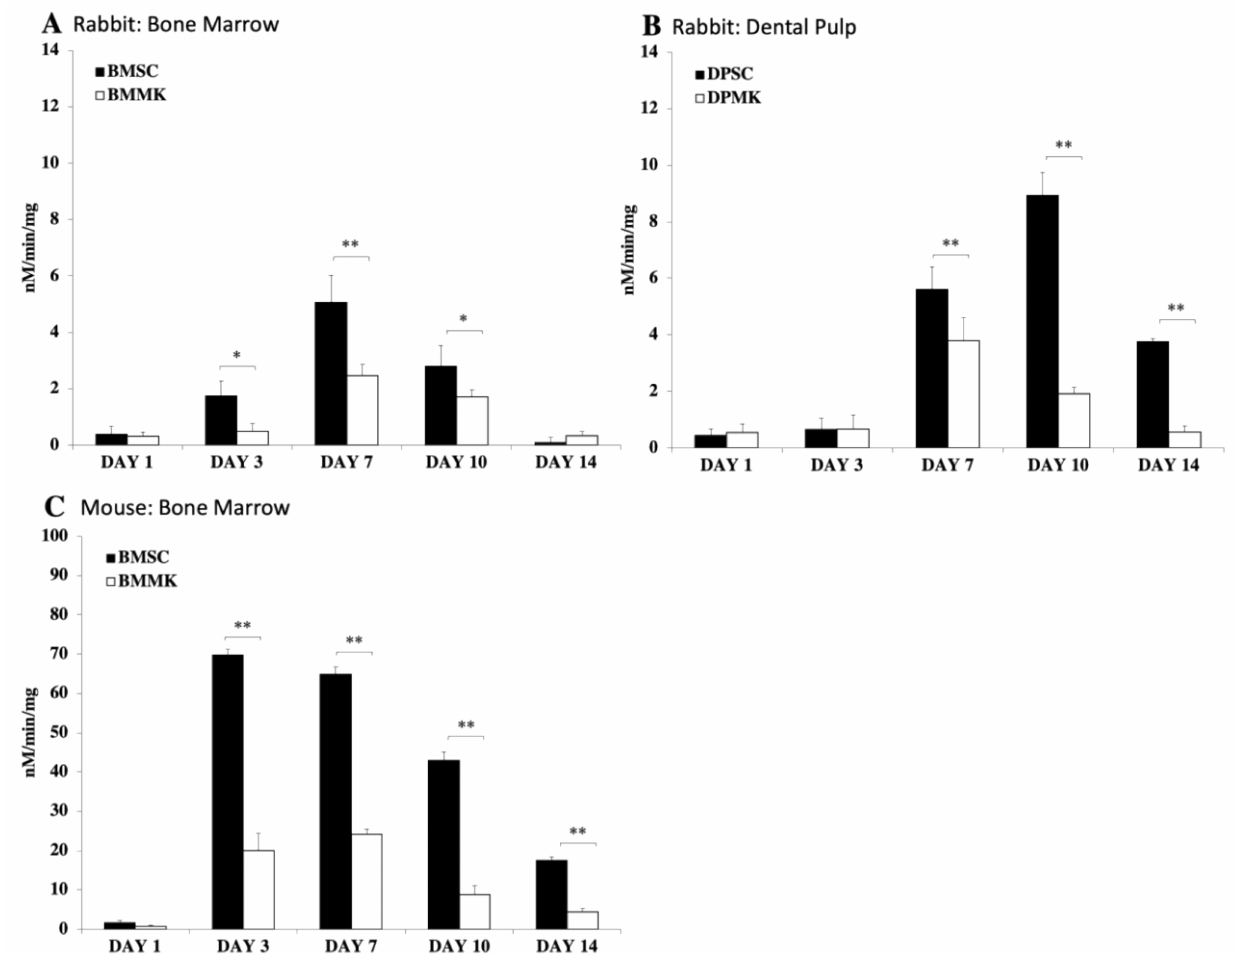
Figure 9. The ALP activity of MSCs co-cultured with or without MKs. ( A ) shows control group of rabbit BMSCs (BMSC) and experimental group of rabbit MKs co-culture with rabbit BMSCs (BMMK). ( B ) shows control group of rabbit DPSCs (DPSC) and experimental group of rabbit MKs co-cultured with rabbit DPSCs (DPMK). ( C ) shows control group of mouse BMSCs (BMSCs) and experimental group of mouse MKs co-cultured with mouse BMSCs (BMMK). ALP activity was assessed on days 1, 3, 7, 10, and 14. ALP activity was calculated per min and normalized per mg of proteins. Decreased levels of ALP activity are observed when MSCs co-cultured with MKs at different time-points. Error bars reflect standard deviation of the mean. Significant difference is indicated by error bars: * = p < 0.05 and ** = p < 0.01